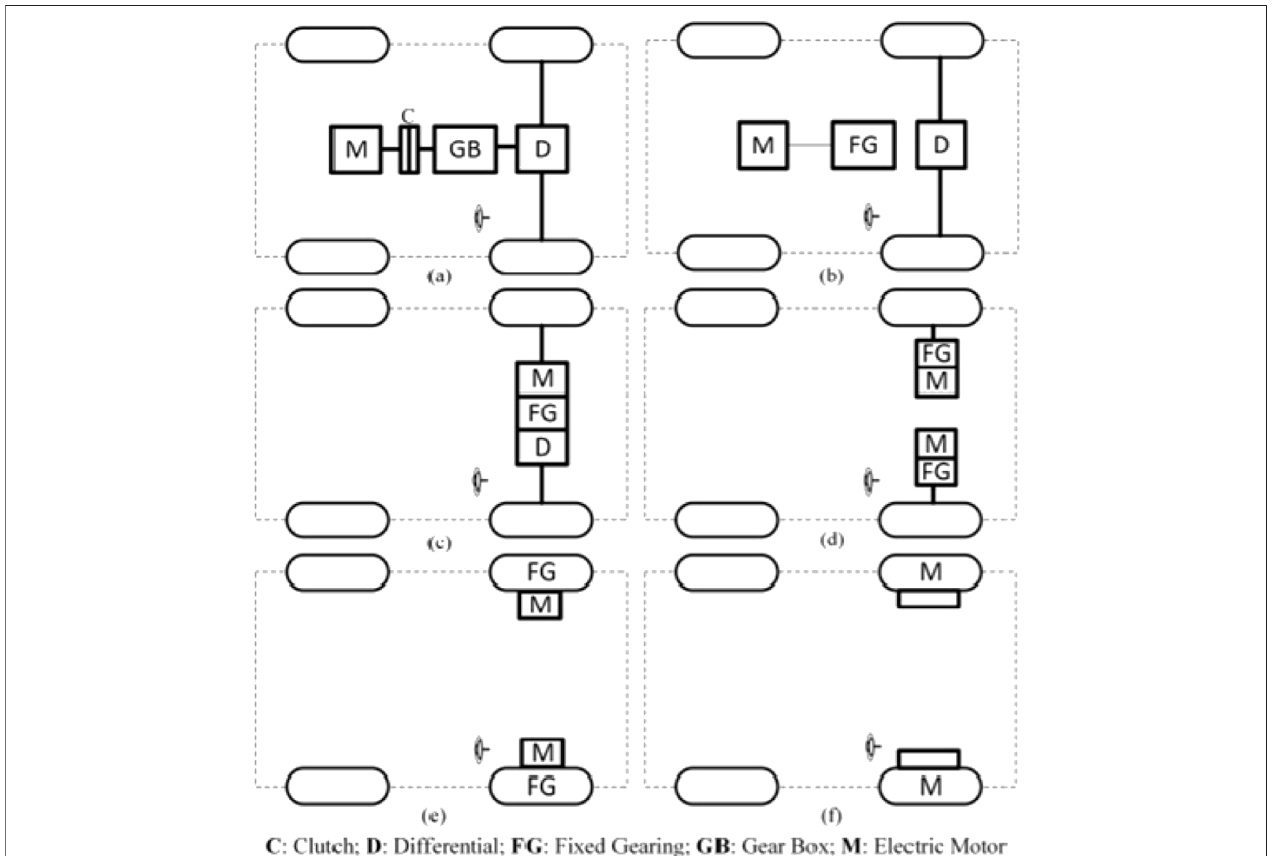
FIGURE 5 | Different BEV con fi gurations of front wheel drive (Chan,